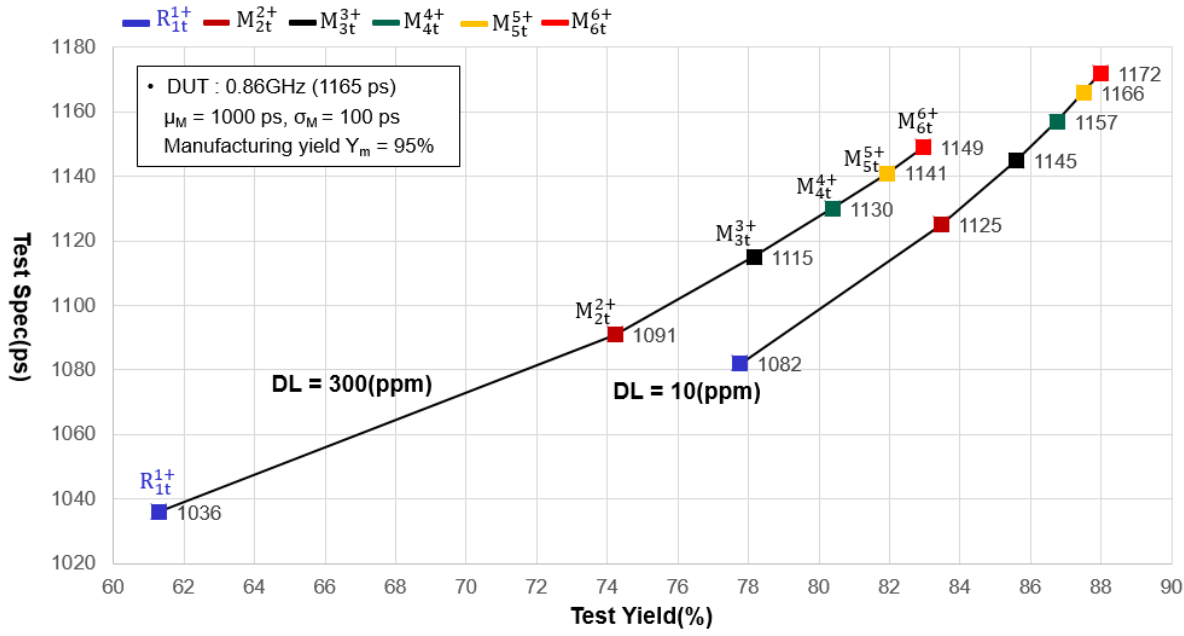
Figure 10. Test yields corresponding to different numbers of multiplex testing.